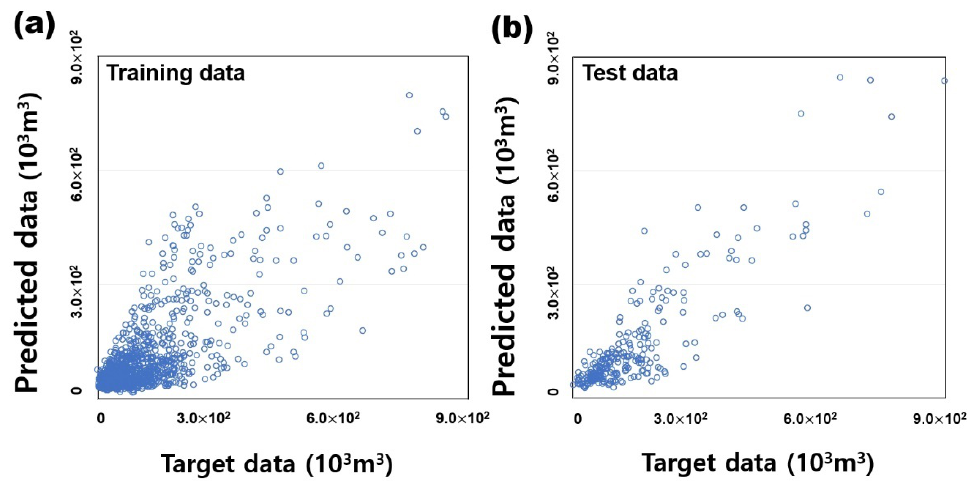
Figure 12. Results of validation of training and test data for 12 months cumulative gas production. ( a ) training data; ( b ) test data. Table 6. Comparison of performance metrics of training and test data.